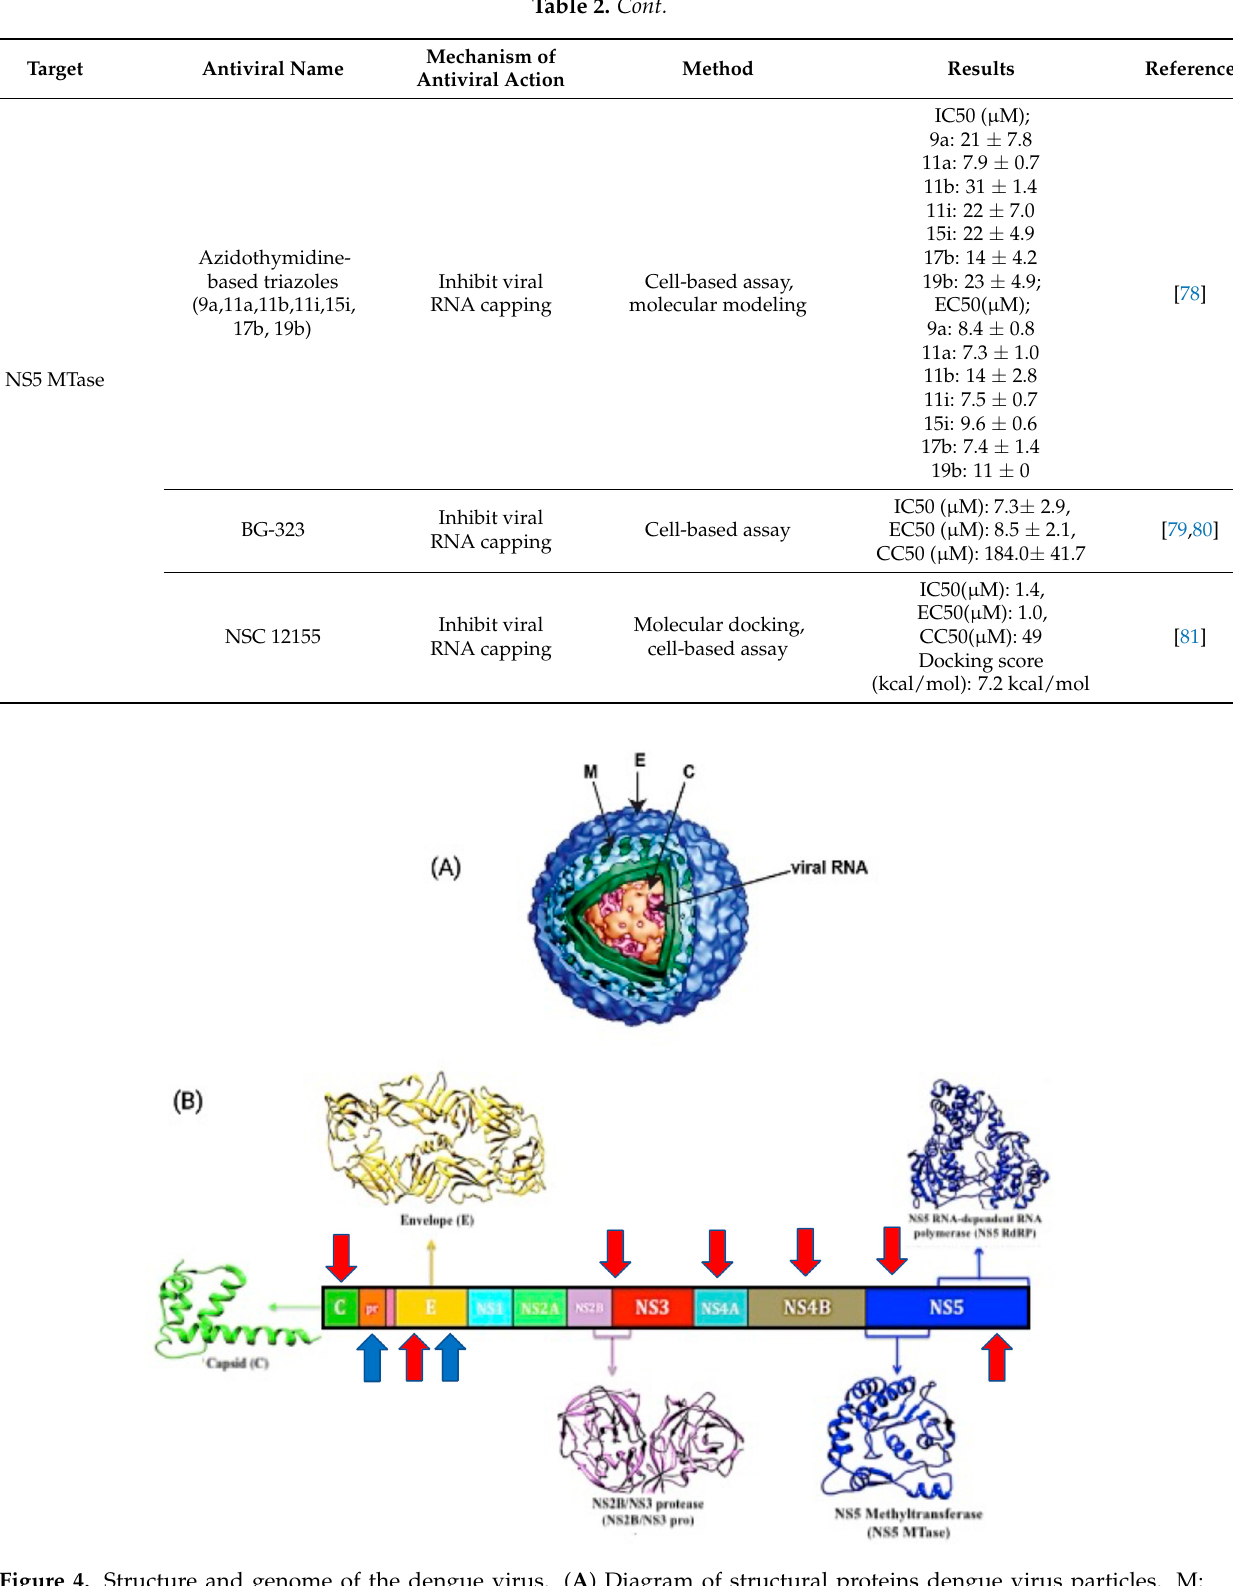
Figure 4. Structure and genome of the dengue virus. ( A ) Diagram of structural proteins dengue virus particles. M: membrane, E: envelope, C: capsid. ( B ) Diagram of the flavivirus genome organization and expression: structural (S) and nonstructural (NS) proteins. Dengue vaccine target antigens and antiviral target proteins discussed in this review are marked with blue and red arrow, respectively. (Figure modified from Nncube, N.B. et al., 2018). Table 2. Summary of dengue potent inhibitors based on their target.